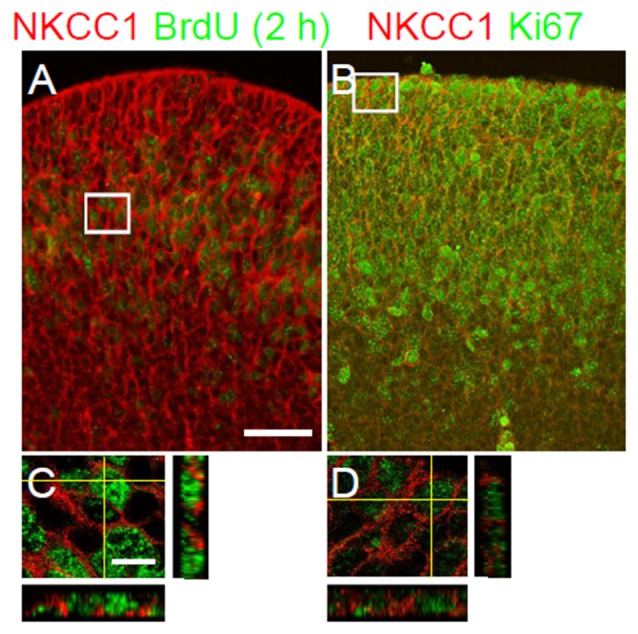
NKCC1-expressing cells are proliferating cells in the proliferative zones. (A,B) Co-labeling of NKCC1 together with bromo-deoxyuridine (BrdU; n = 2) (A), and with Ki67 (n = 2) (B) in the ganglionic eminence at E12.5. The merge images show the co-localization of NKCC1 and BrdU (A), and Ki67 (B). High-magnification confocal images of the boxed area in (A,B) are shown in (C,D), respectively. Scale bar 100 μm in (A), 20 μm in (C).